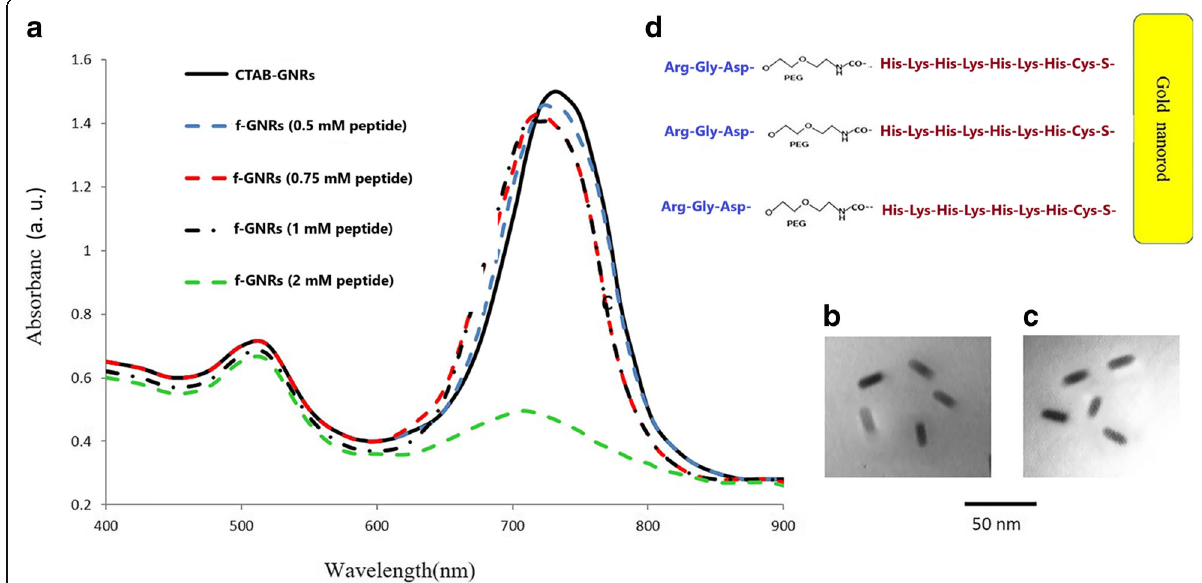
Fig. 1 a UV – Vis absorption spectra of CTAB-GNRs (black solid line) and peptide-functionalized GNRs using different peptide concentrations (dashed lines). TEM image of CTAB-GNRs ( b ) and peptide-f-GNRs ( c ), Scale bar: 50nm. Schematic diagram of peptide-conjugated GNRs ( d